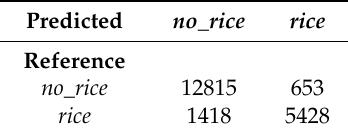
Table 2. Confusion matrix for OCSVM 2014 compared to our reference dataset.